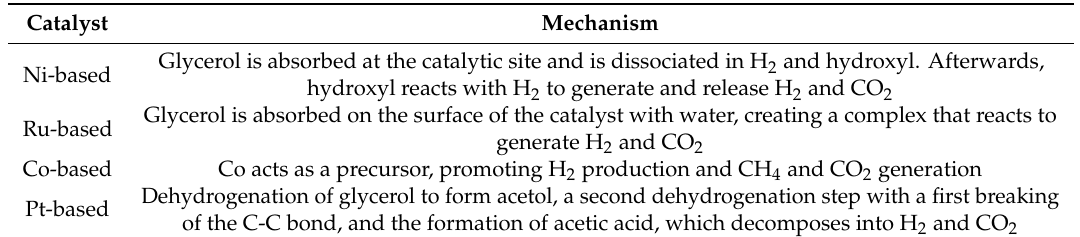
Table 2. Main reaction mechanisms in heterogeneous catalysts during steam reforming (proposed by Bagnato et al. [3]).